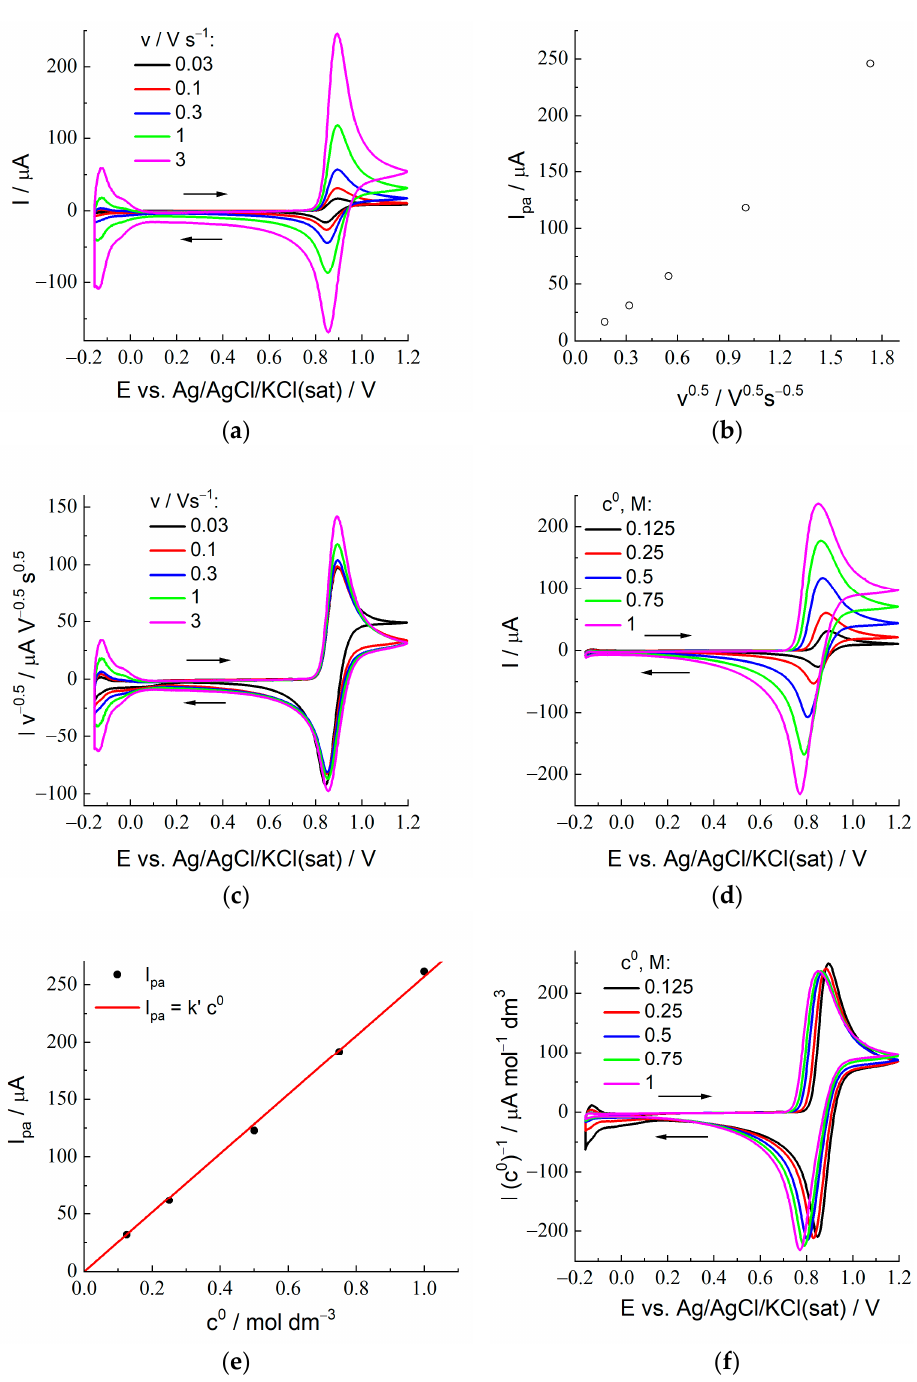
Figure 3. Cyclic voltammograms for the Pt electrode (diameter: 1 mm) coated with Nafion 212 membrane in contact with 2 M sulfuric acid with the addition of HBr, c 0 : ( a ) CV plots for a set of scan rates between 30 mV/s and 3 V/s (its values are indicated in the figure) for c 0 = 0.125 M (data for all HBr concentrations are given in Figure S1). ( b ) Dependence of the forward (oxidation) peak current, I pa , on v 1/2 for data of ( a ). ( c ) “Normalized CV plots”, i.e., dependences of I/v 1/2 on E for various scan rates, data of ( a ). ( d ) CV plots for a set of the HBr concentrations, c 0 (its values are indicated in the figure), for 100 mV/s (data for all scan rates are given in Figure S2). ( e ) Dependence of the anodic peak current of the voltammograms, I pa (black), on the HBr concentration in the external solution, c 0 , in ( d ). The straight line (red), I pa = k’ c 0 , illustrates the proportionality of the anodic peak current, I pa , to the HBr concentration in solution. ( f ) “Normalized CV plots”, i.e., dependences of I/c 0 on E for various HBr concentrations, data of ( d ). See legend to Figure 2 for notations and values of